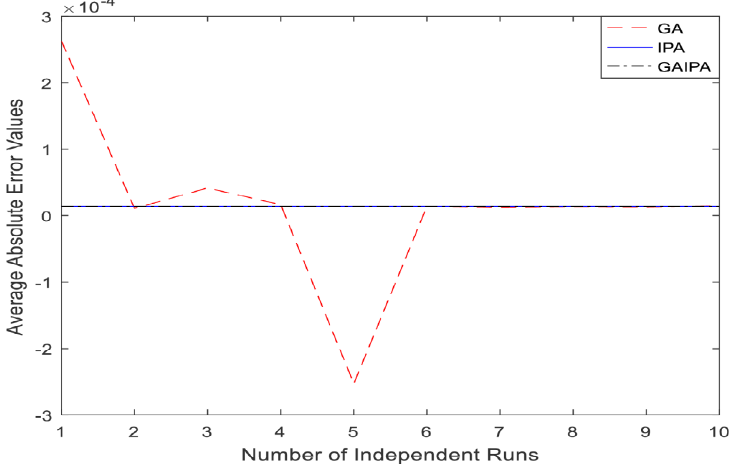
Fig 7. Graphical representation of average absolute errors for Example #02 when δ = 0.5 using B-Polynomial.